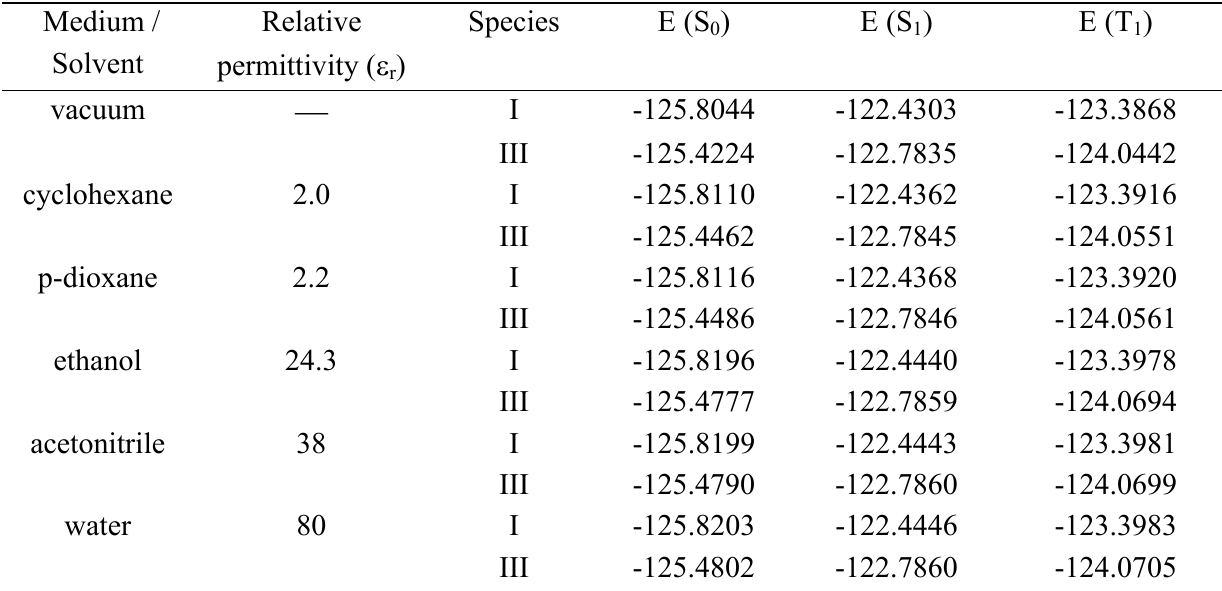
Table 5. Calculated S isolated and solvated conditions (Onsager’s cavity radius, a = 5.57